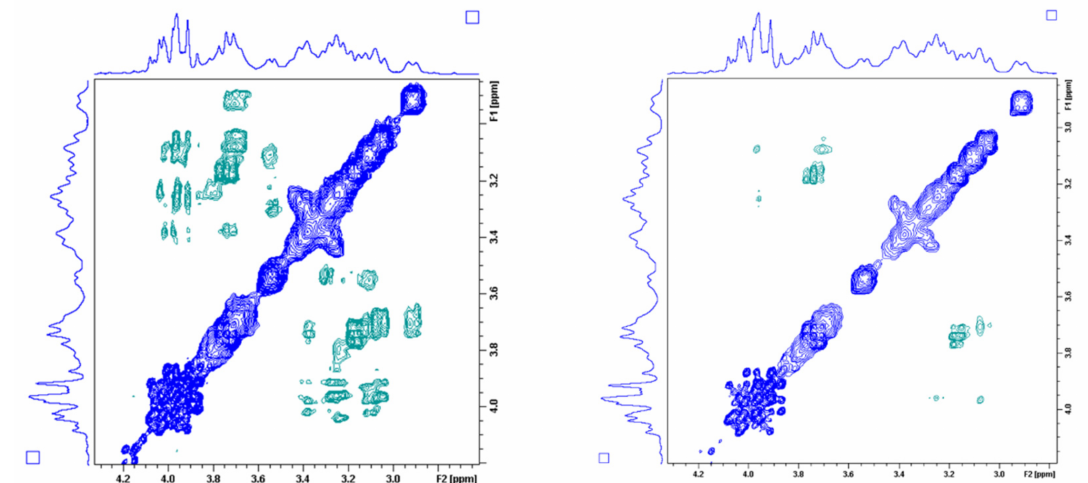
Figure 8. Expanded area of the 1 H 2D NOESY spectrum of the Y(DO3A-BACE) − complex at 80 ◦ C shown in Figure S13. The left spectrum has an increased intensity relative to the right one. Blue cross peaks are in the same phase as the diagonal, while the green ones are in the opposite